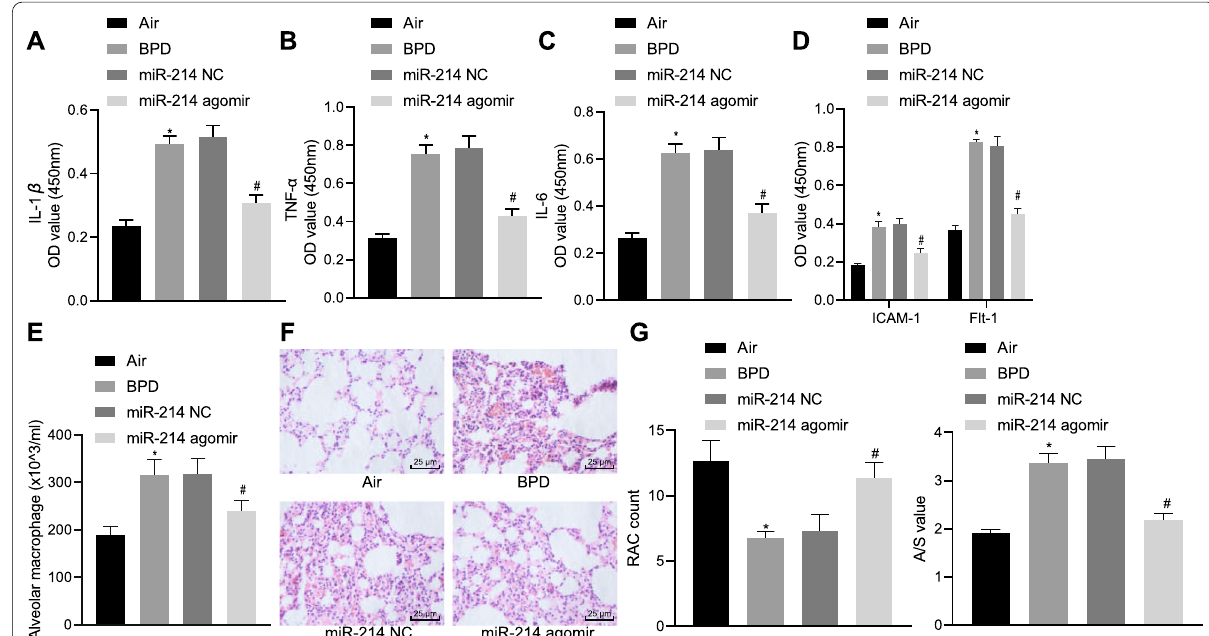
Fig. 3 miR‑214 overexpression induces alveolarization in neonatal rats with BPD. BPD neonatal rats were injected with miR‑214 NC and miR‑214 agomir. A ELISA quantification of the proinflammatory factor IL‑1β in rats. B ELISA quantification of the proinflammatory factor TNF‑ ɑ in rats. C ELISA quantification of the proinflammatory factor IL‑6 in rats. D ELISA quantification of ICAM‑1 and Flt‑1 levels in rats. E Giemsa staining of the number of macrophages in rats. F H&E staining of pulmonary microvascular ( 400). G H&E staining showing the number of alveoli, and alveolar growth. Data × are summarized as